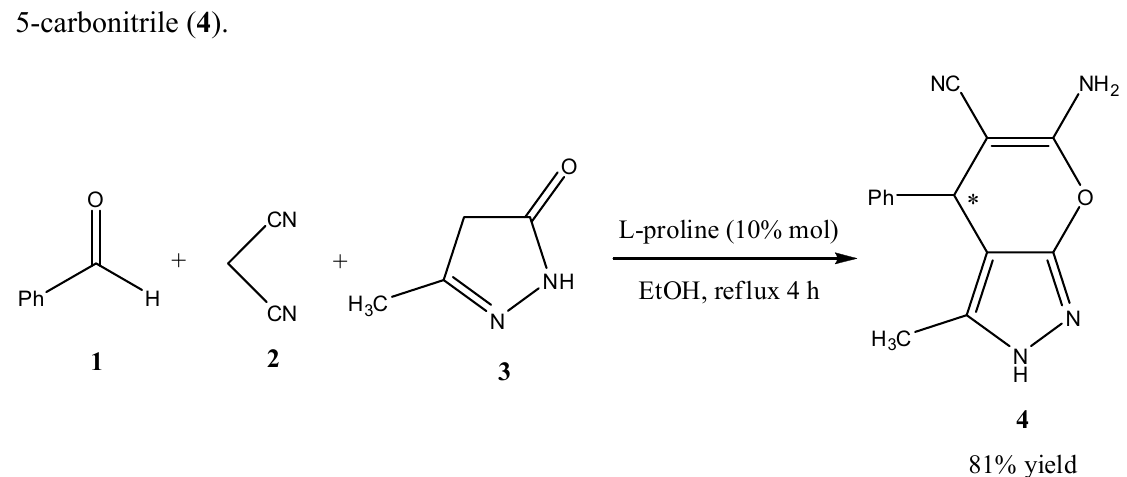
Scheme 1. Synthesis of